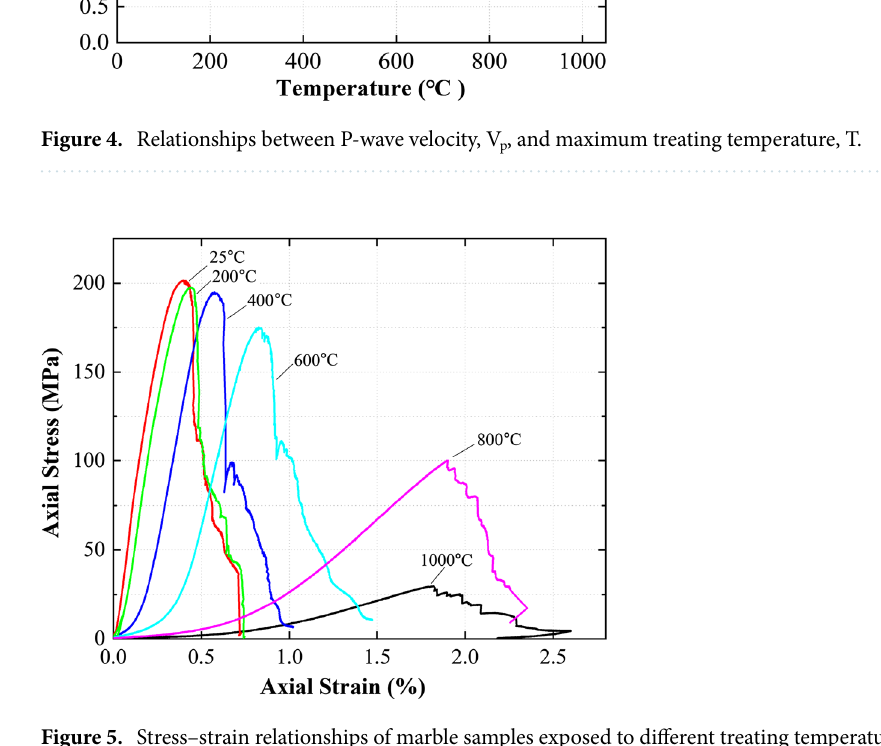
Figure 5. Stress–strain relationships of marble samples exposed to different treating